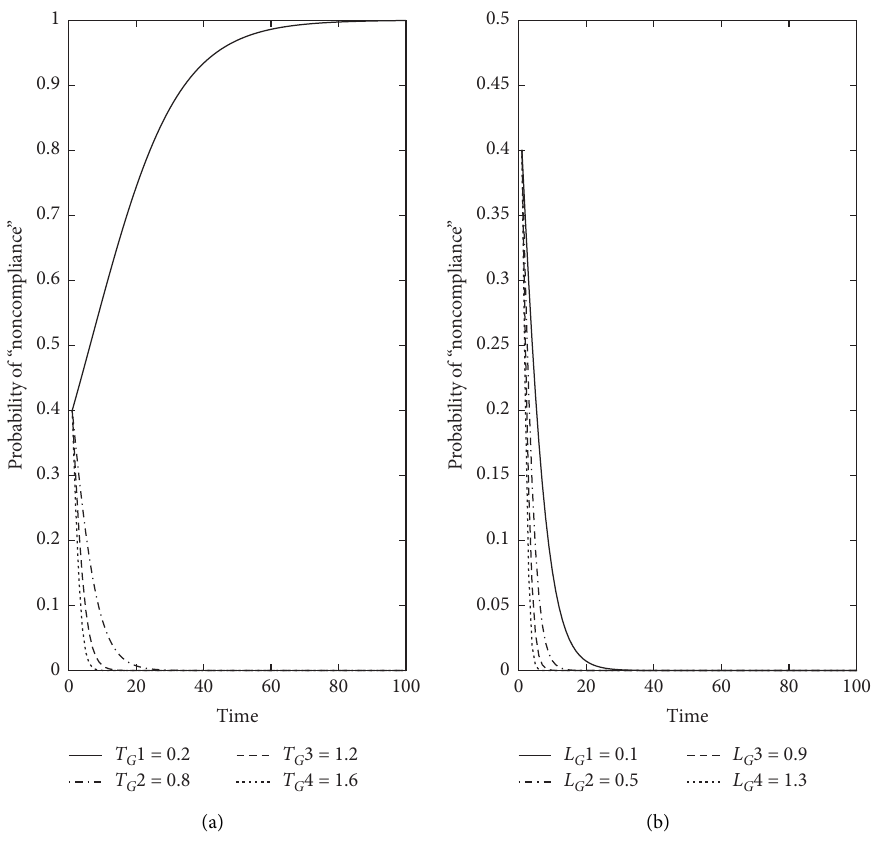
Figure 6: The effects of government fines T